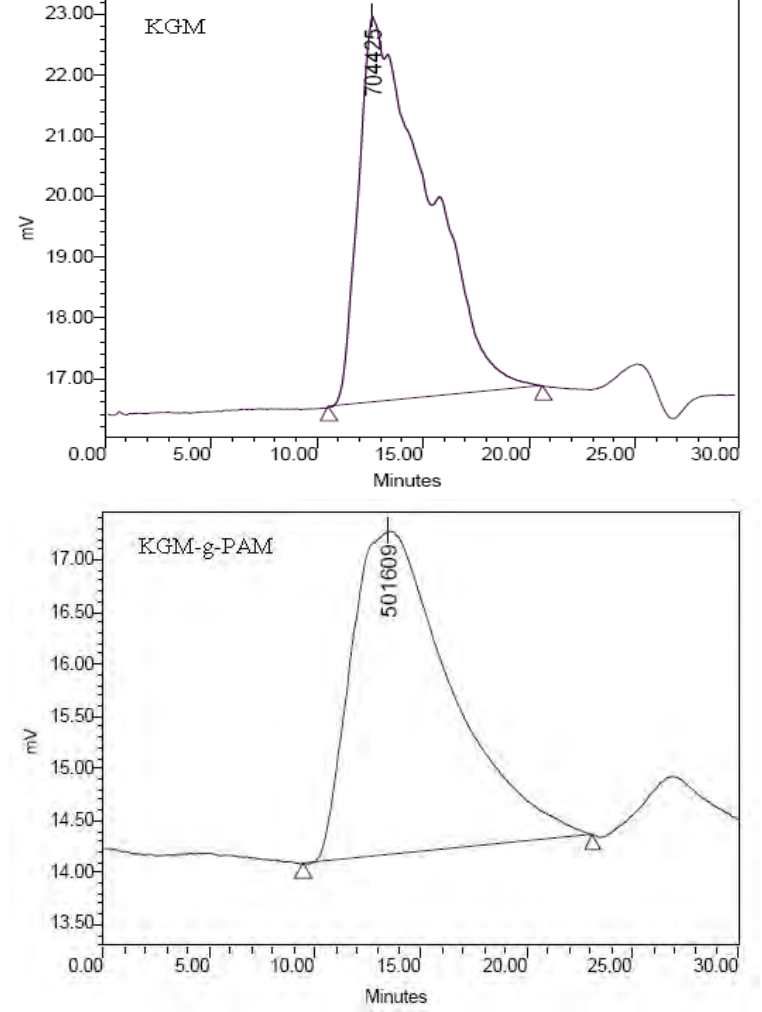
Figure 8. GPC elution curves of KGM and KGM-g-PAM.